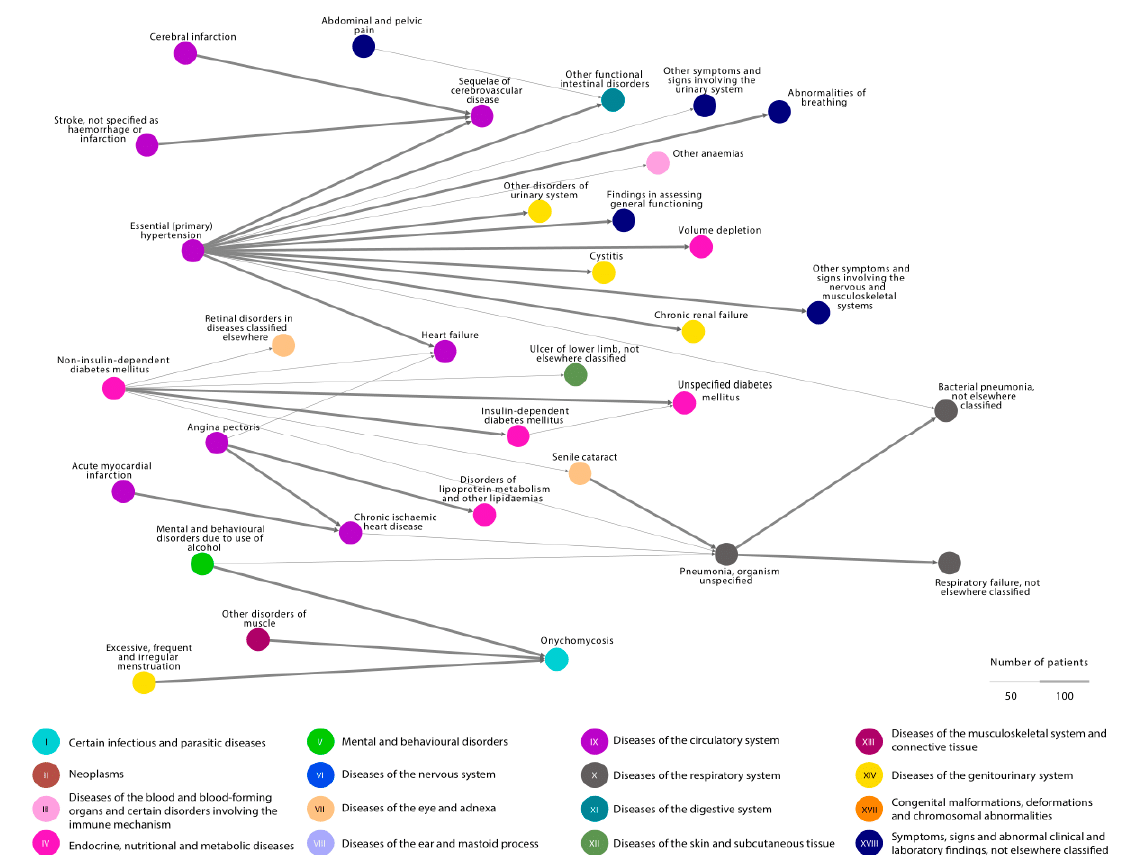
Figure 2. Comorbidity burden and their temporal relations in patients with onychomycosis. All disease pairs illustrated in the figure are overrepresented in patients with onychomycosis compared to controls without onychomycosis. The disease pairs represent a minimum of 50 patients. Thus, the figure illustrates that patients with onychomycosis treated in Danish hospitals often have cardiovascular diseases prior to complications of the first disease, e.g., essential hypertension prior to heart failure and acute myocardial infarction prior to chronic ischemic heart disease prior to pneumonia and respiratory failure. Interestingly, the only diseases occurring in a minimum of 50 patients with onychomycosis are mental disorders due to the consumption of alcohol (green dot); muscle disorders (dark red dot); and excessive, frequent, and irregular menstruation (yellow dot). The different chapters in the 10th version of the International Classification of Disease are illustrated by various colors and Roman